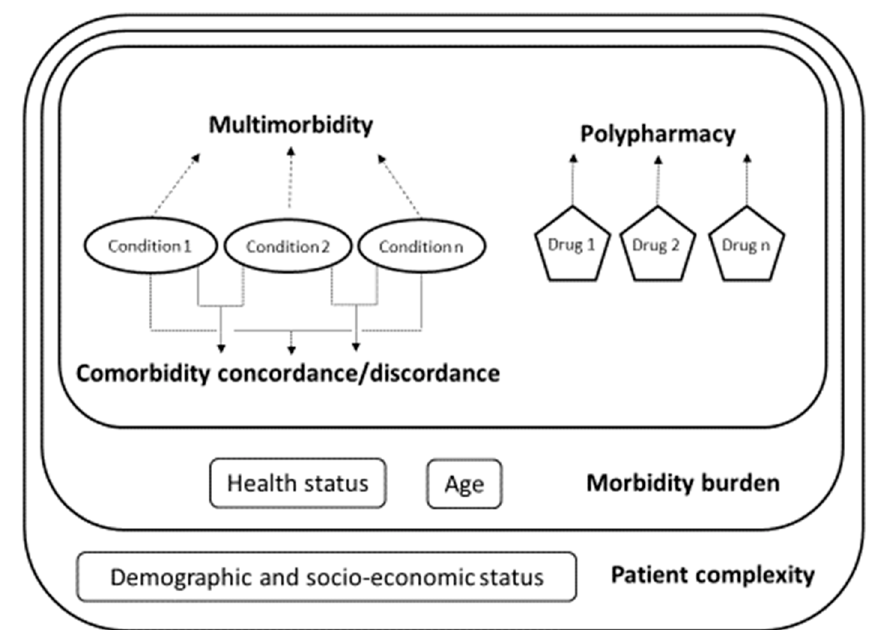
Figure 1. Multimorbidity and related constructs.